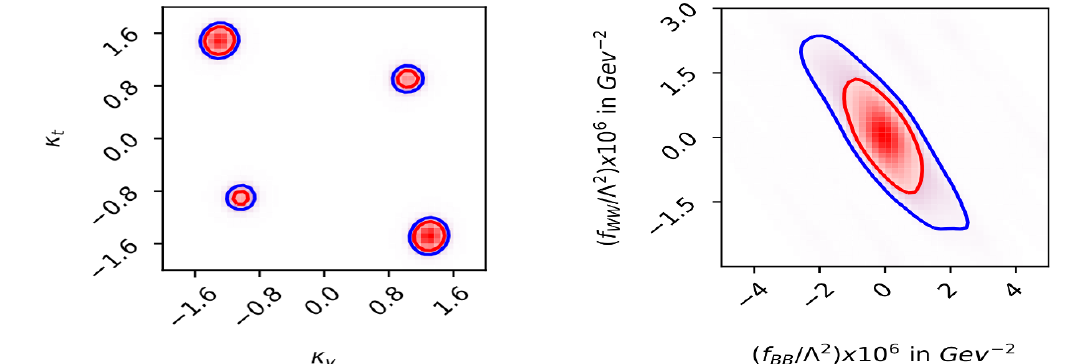
Figure 13 . Allowed regions at 1 (cid:27) (red) and 2 (cid:27) (blue) levels in the parameter space of scale factors and dimension-6 couplings in Flipped 2HDM.